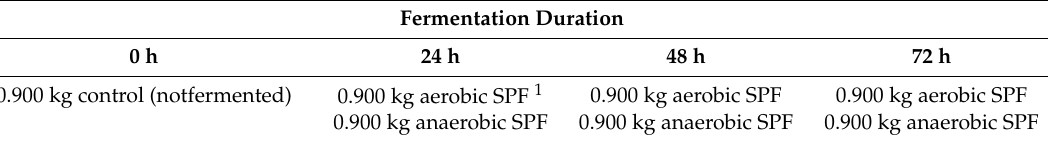
Table 1. Laboratory experiment